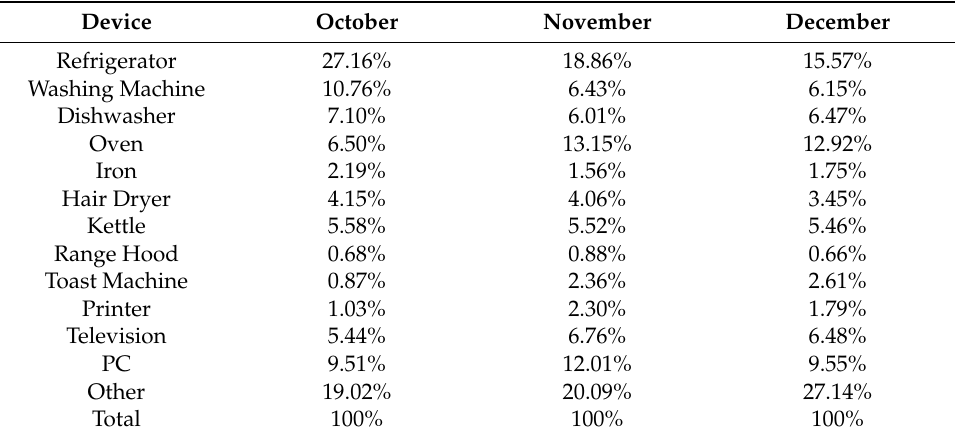
Table 4. The energy consumption ratios of each home appliance from October to